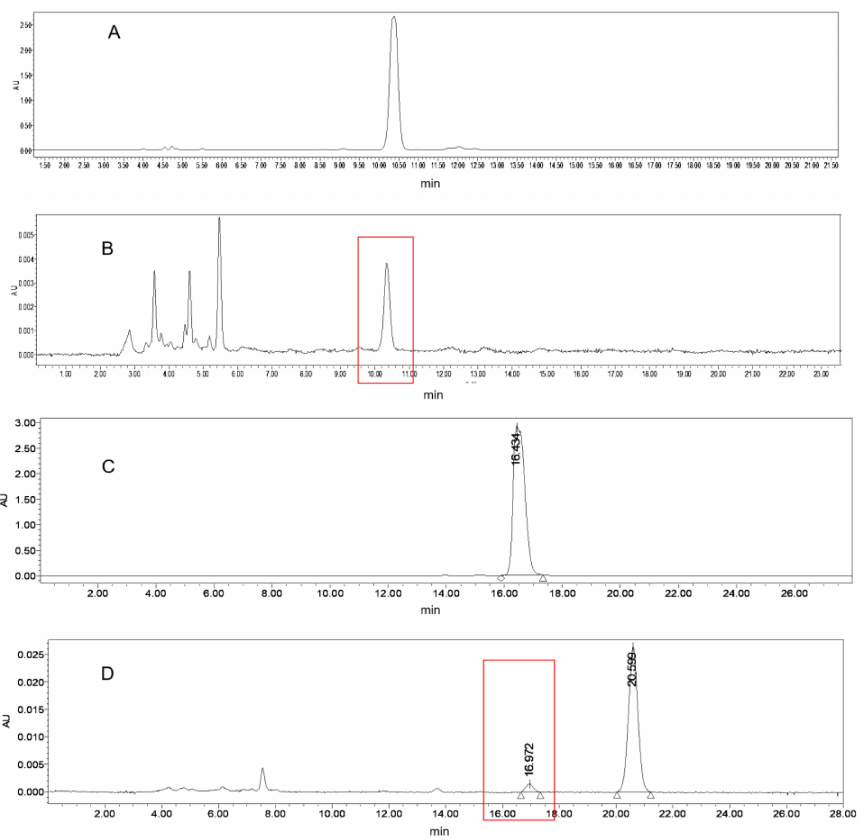
Figure 4. Analysis of reaction products (( A ), γ -TQ standard in HPLC; ( B ), the peak of γ -TQ in the sample; ( C ), tocored standard in HPLC; ( D ), the peak of tocored in the